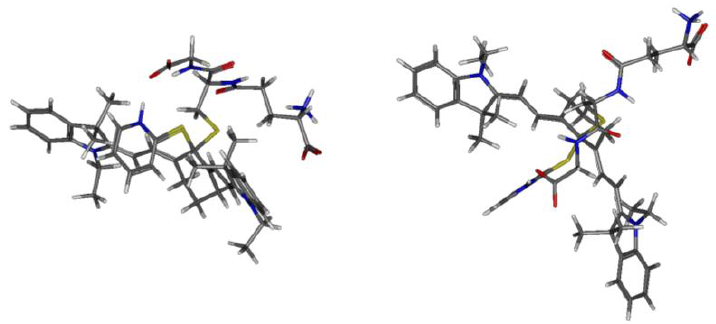
Figure 4. Optimized structure of the tetrahedral intermediate resulting from the nucleophilic addition of GSH to 1 (PCM-ωB97XD/6-31+G(d)). Left : side view, Right : top view. See Movie 1 for an animated version of the structure.